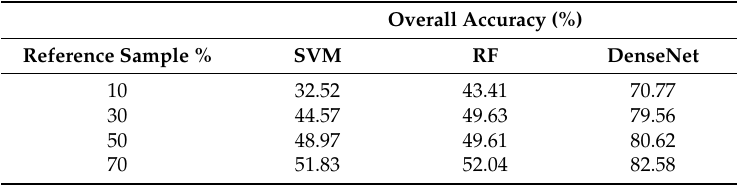
Table 9. Overall accuracy for SVM, RF and DenseNet classifiers for eight dominant tree species using varying percentages of the total samples for each individual